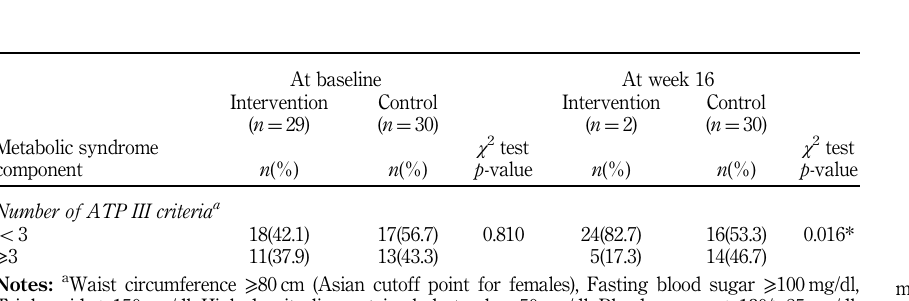
metabolic syndrome components at baseline and the 16th